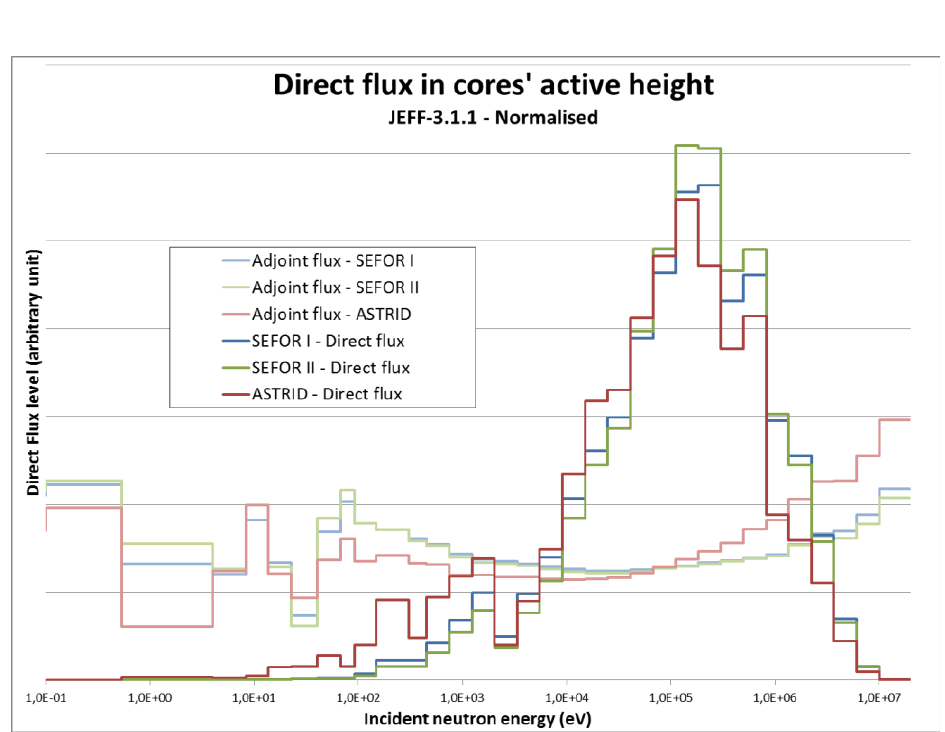
to the reactivity. g